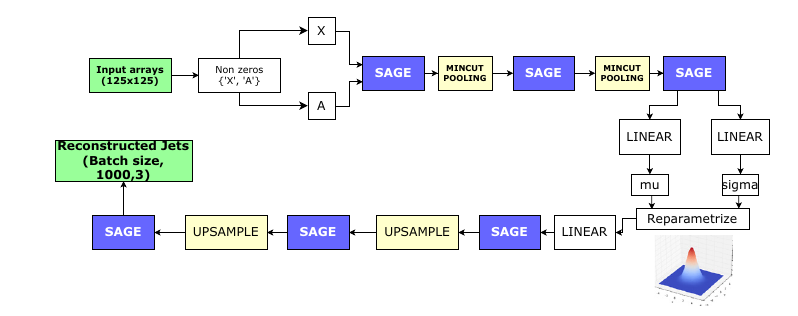
Figure 2. Model architecture of the Graph Variational Autoencoder showing GraphSAGE layers and pooling